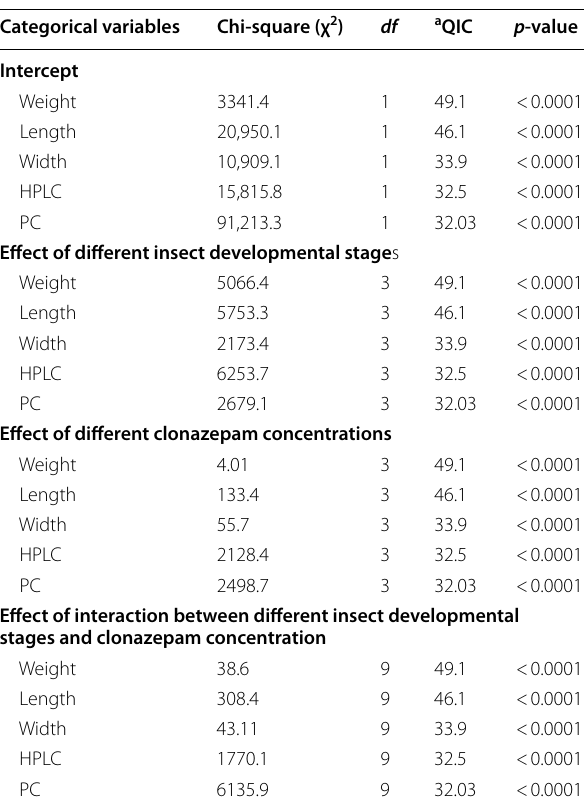
Table 1 Testing the interaction of different concentrations of clonazepam (25, 50, or 100 mg/ml) on different developmental stages (second, early third, and late third larval instars and prepupa) of Sarcophaga argyrostoma , in terms of morphological measurements and, analytical and biochemical analyses, using generalized estimating equation